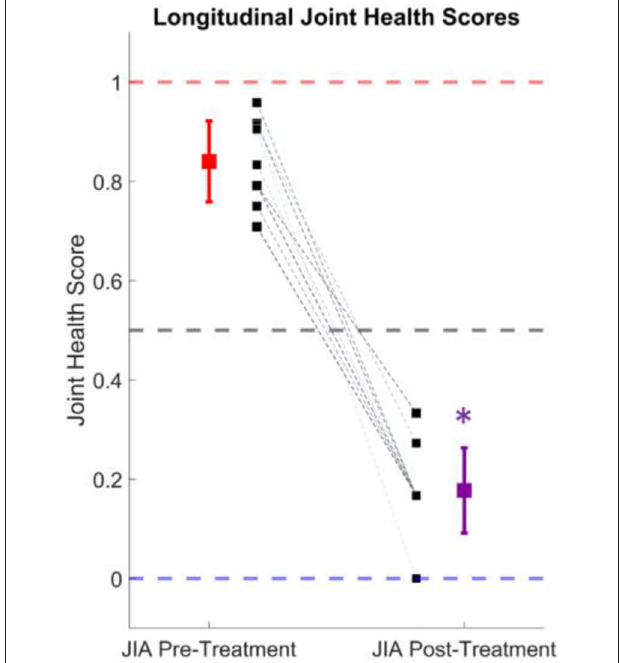
FIGURE 5 | Longitudinal joint health score tracking. The average joint health score, which describes the probability of having JIA, dropped from 0.84 ± 0.08 to 0.19 ± 0.09 after successful treatment of the condition in 10 subjects. The individual subject scores are denoted by the black squares and dashed lines. The mean and standard deviation of the actively inflamed subjects with JIA is shown in red, and the purple marker indicates the mean and standard deviation at follow-up. This drop in joint health score was statistically significant ( p <